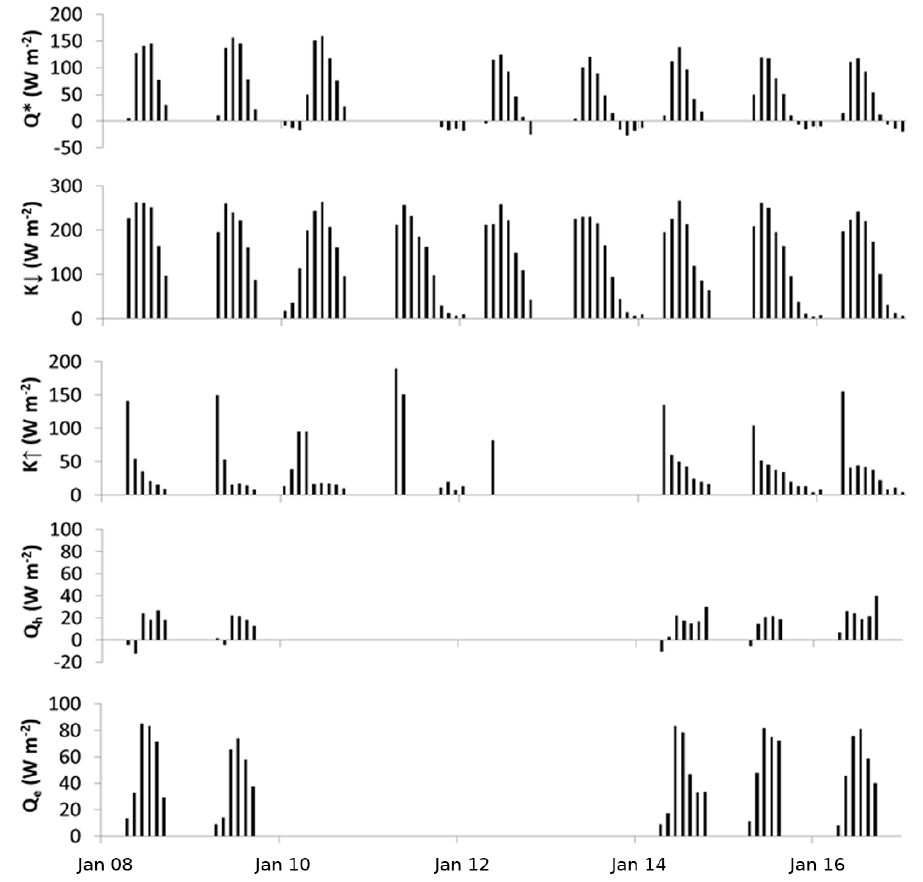
Figure 6. Monthly average radiation and energy fluxes at the Landing Lake climate tower in 2008–2016. Nomenclature is identical to that in Fig.